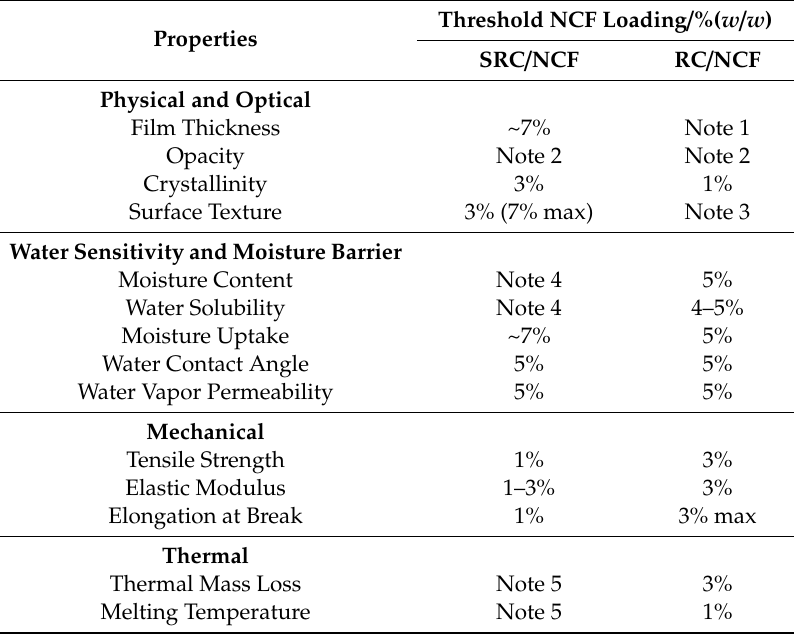
Table 3. Threshold NCF loadings for the tested properties of the SRC and RC